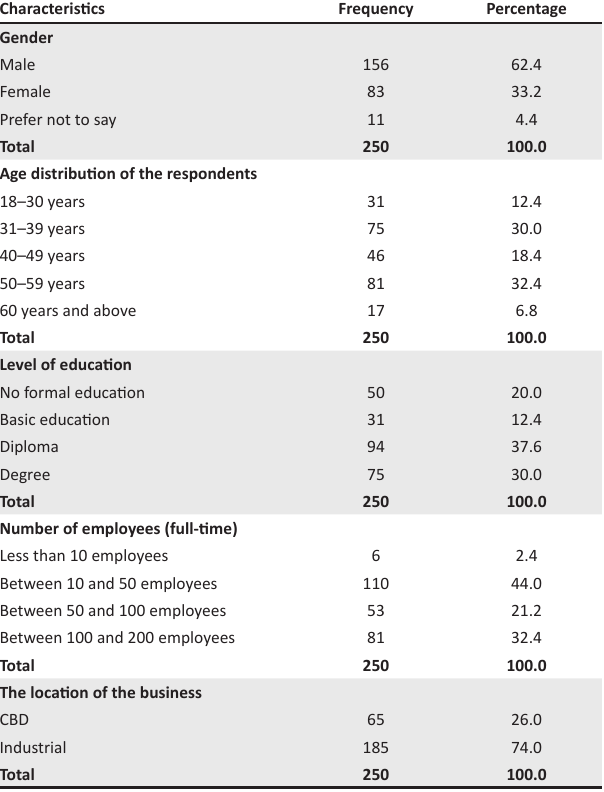
TABLE 1: Sample demographic